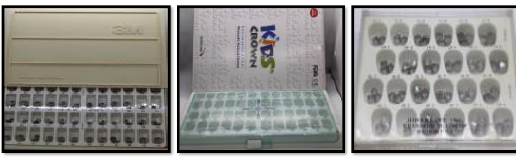
Figure 5: 3M crowns, Kids crowns, Rihany crowns.